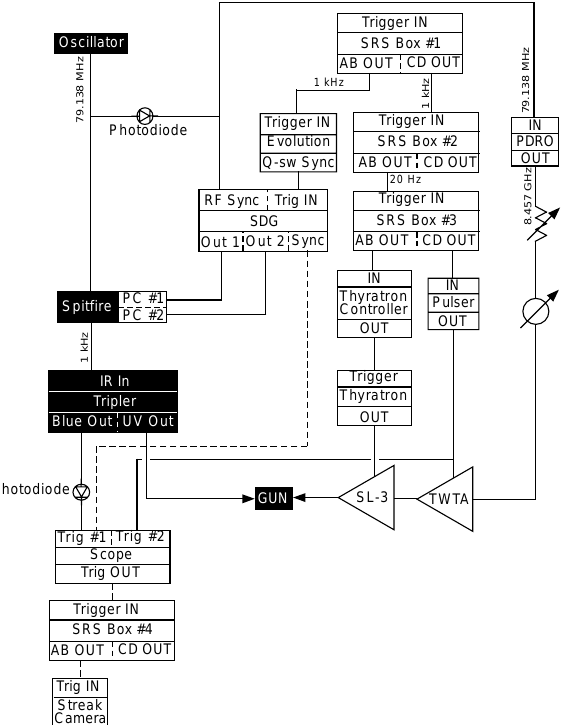
FIG. 9. Diagram of trigger, laser, and rf signals in the entire experimental setup. Black boxes are laser elements, white boxes are electronic elements. SRS boxes are Stanford Research Sys- tems DG535 delay generators, SDG is the Positive Light syn- chronization and delay generator, and PC is Pockels cell. See text for full description. boxes represent electrical components. This system